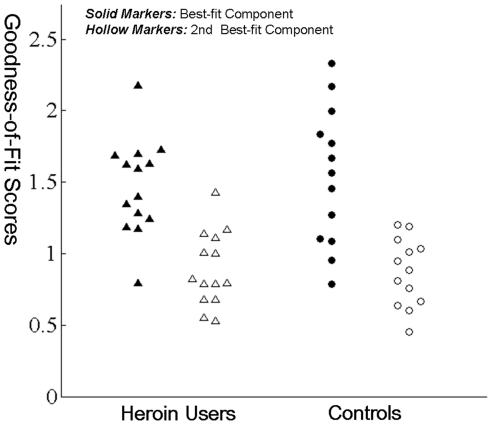
Scatter Plots of the Goodness-of-fit Scores.Triangles  =  Heroin users, Circles  =  Controls; Solid markers: Goodness-of-fit Scores of best–fit component, Hollow markers: Goodness-of-fit Scores of second best–fit component.